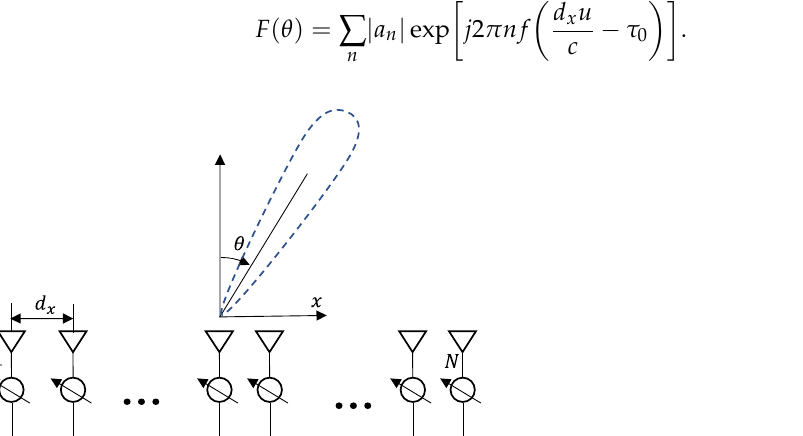
Figure 4. 1D array antenna.